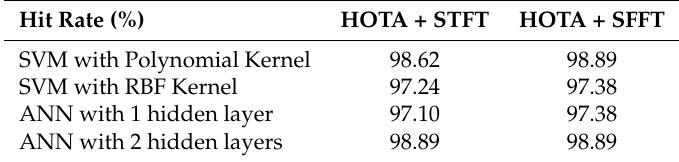
Table 5. Hit rates obtained in each of the local optimal diagnostic systems generated by the